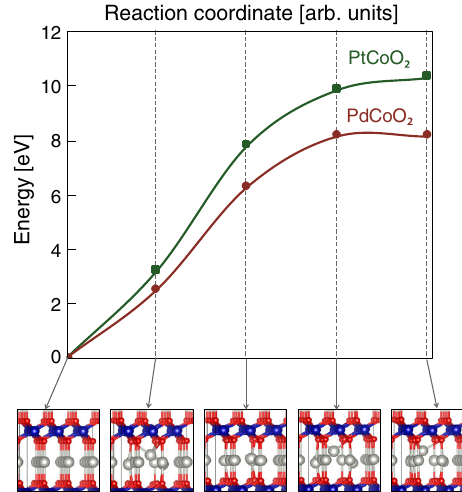
FIG. 11. Adiabatic barrier for Frenkel pair formation in PdCoO 2 and PtCoO 2 , from nudged elastic band DFT calcula-